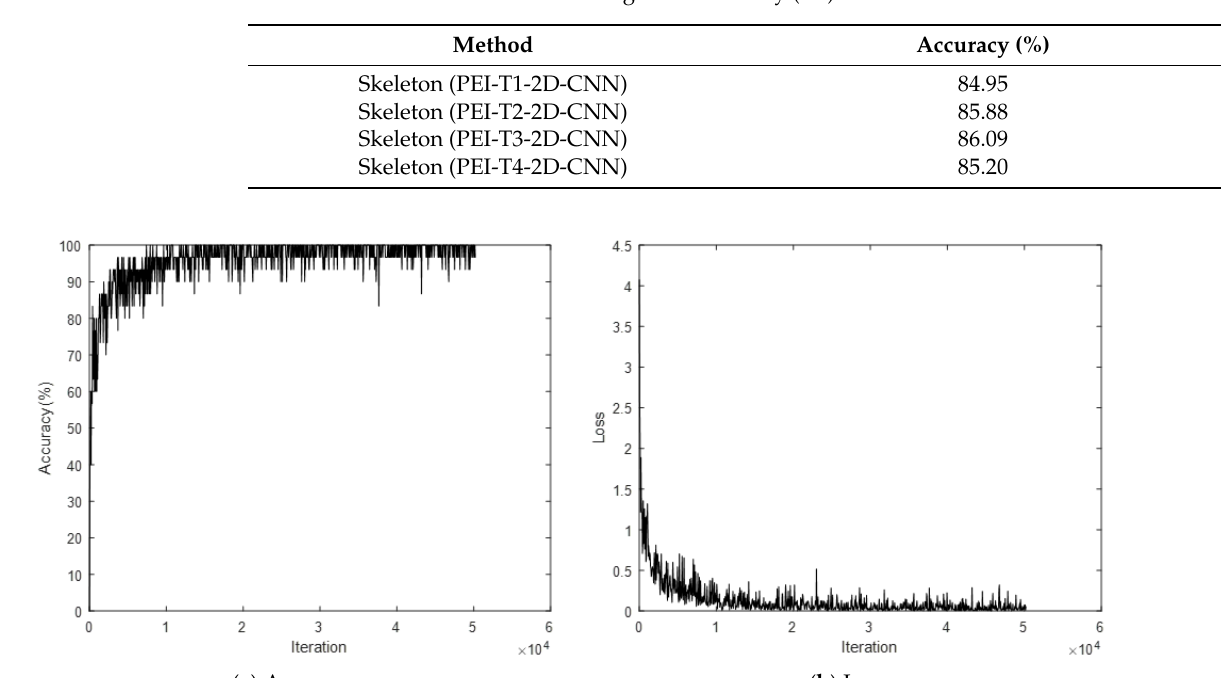
Figure 17. Example of PEI-T3 conversion from a skeleton. Table 2. Skeleton-based behavior recognition accuracy (CS).